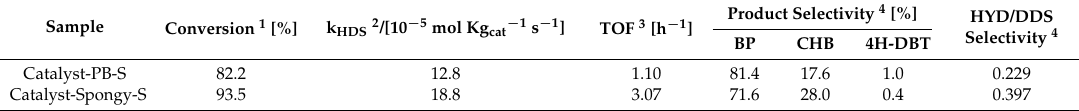
Table 5. The HDS conversion, initial reaction rate constant k HDS , TOF and product selectivity of HDS catalysts at 300 ◦